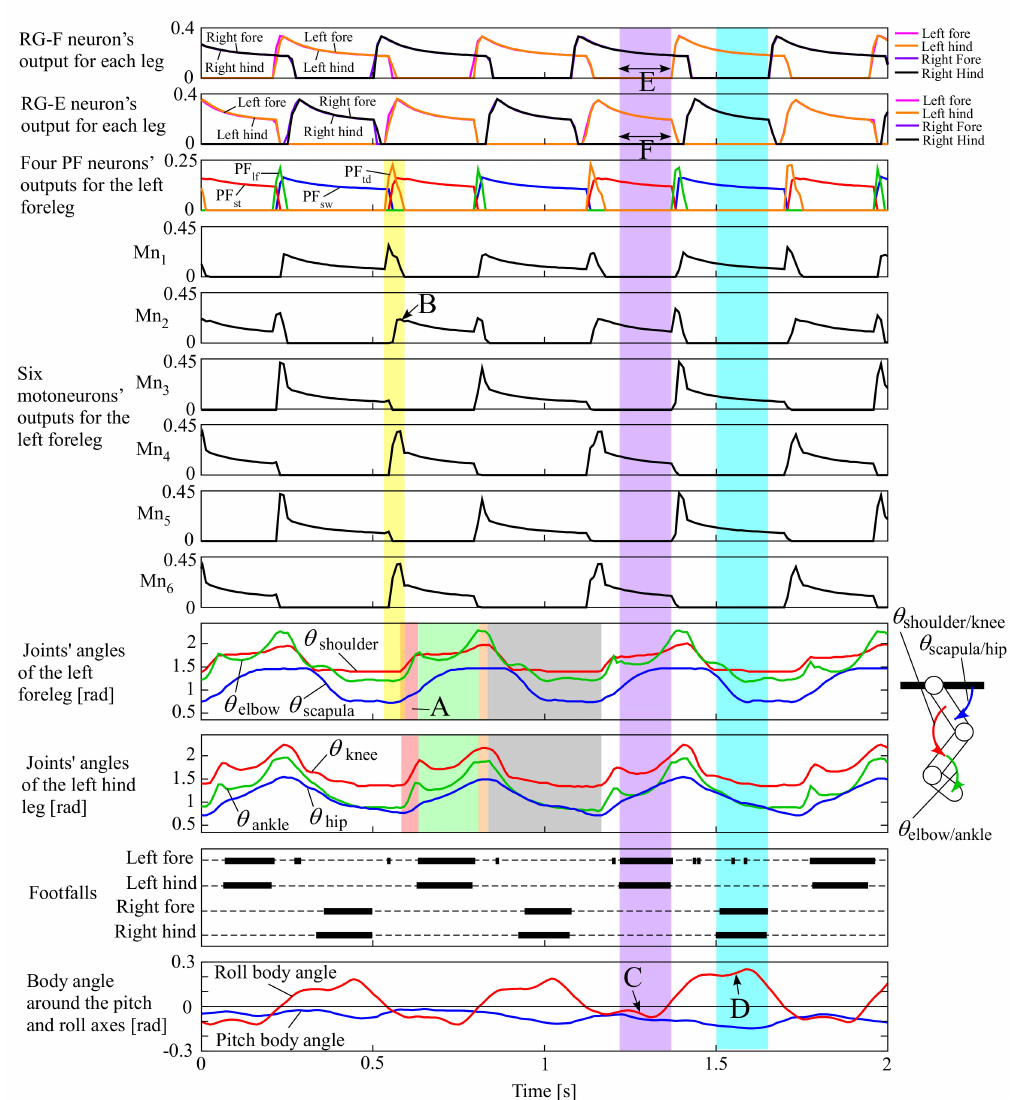
Figure 10. Experimental results of the pace running of our quadruped robot, which include the outputs from the RG flexor (RG-F) and RG extensor (RG-E) neurons for the four legs, the four PF neurons (PF td , PF st , PF lf , and PF sw ), and the six motoneurons (Mn 1–6 ) only for the left foreleg as a representative, the joints’ angles of the left fore and hind legs (the origin and orientation are shown in the leg diagram), the footfalls for the four legs (thick lines represent the stance phases), and the body angles around the pitch and roll axes (positive when tilted forward and rightward, as shown by white arrows in 1 (cid:13) of Figure